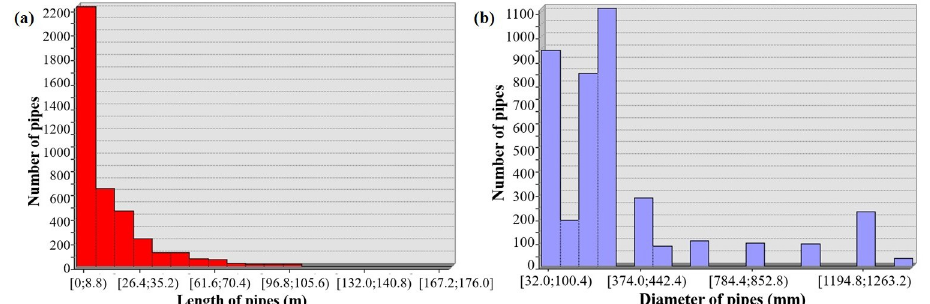
Fig 12. Length and diameter distribution of water supply pipelines in Shengpu subregion. (a) Length, (b) Diameter.